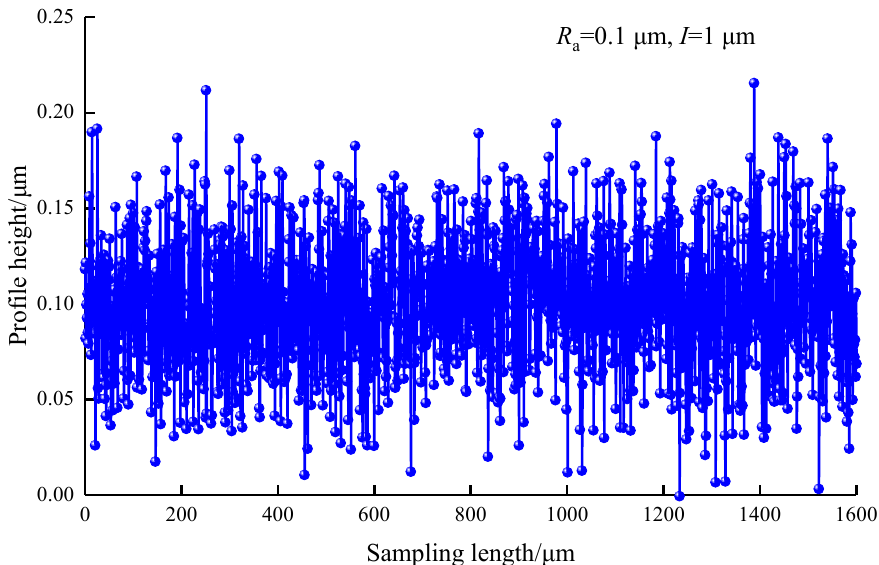
Figure 2. Simulated profile curve of rough surface based on Monte Carlo random normal distribution sampling.